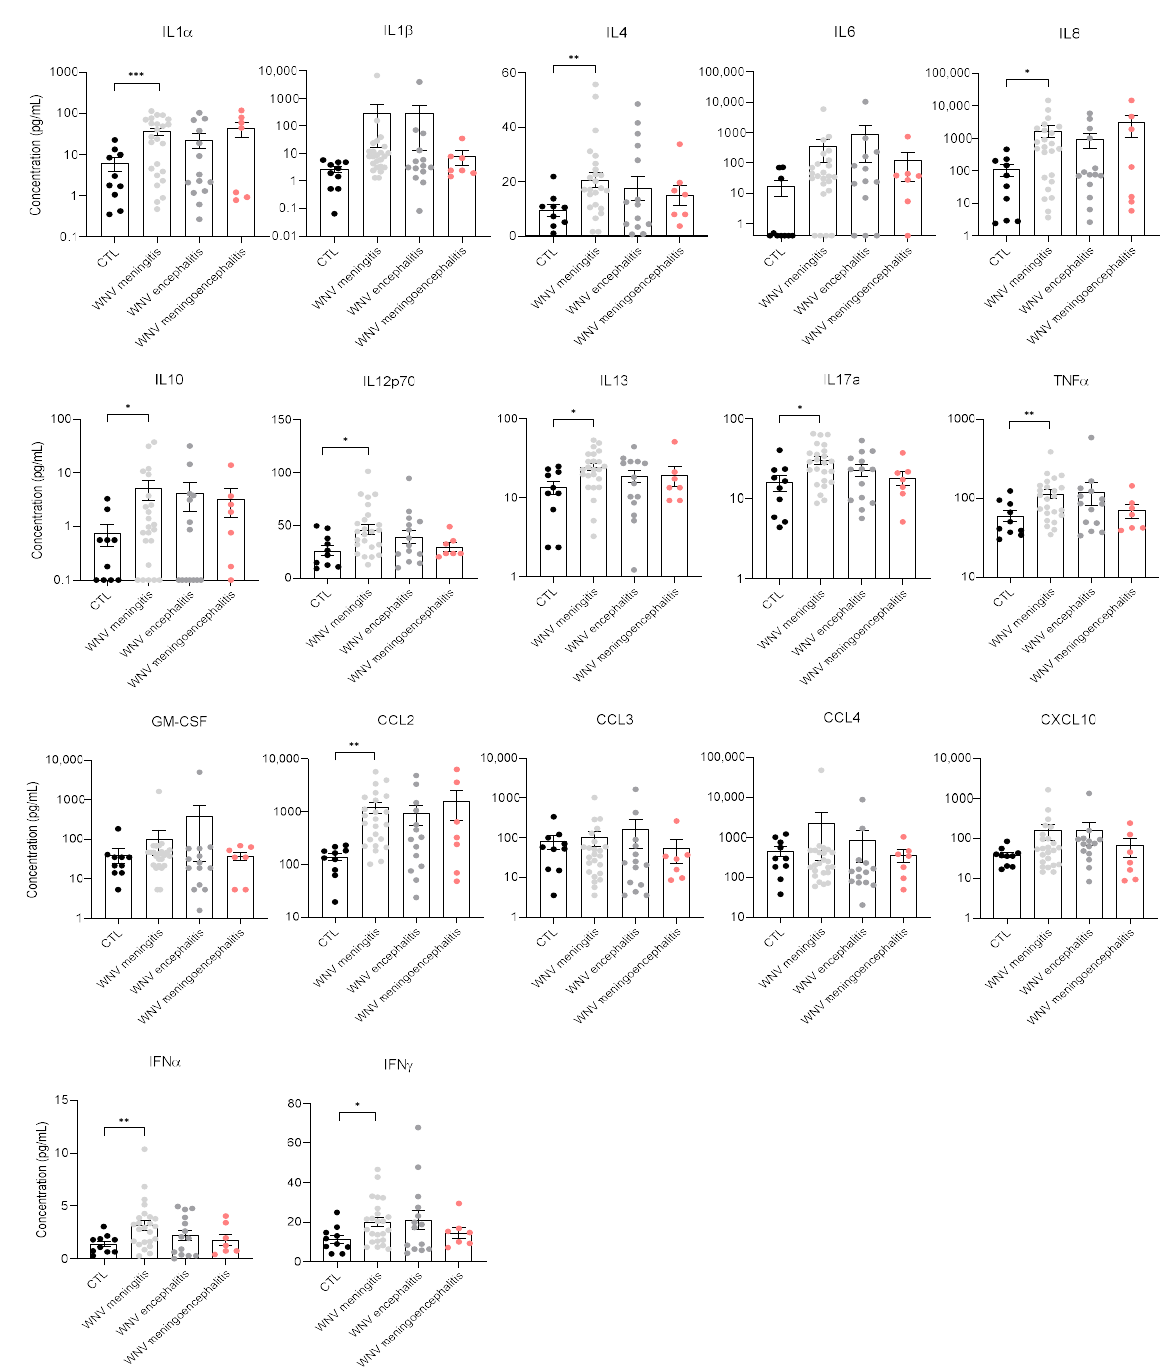
Figure A2. Same inflammation profile in patients with meningitis, encephalitis, or meningoencephali- tis. Plasma concentration in pg/mL of different pro-inflammatory markers of non-infected CTL (black), WNV-meningitis (light grey), WNV-encephalitis (dark grey) and WNV-meningoencephalitis (light red) humans, measured by multiplex bead-based ELISA. Bars show means ± SEM (* p < 0.05, ** p < 0.01, *** p < 0.001).